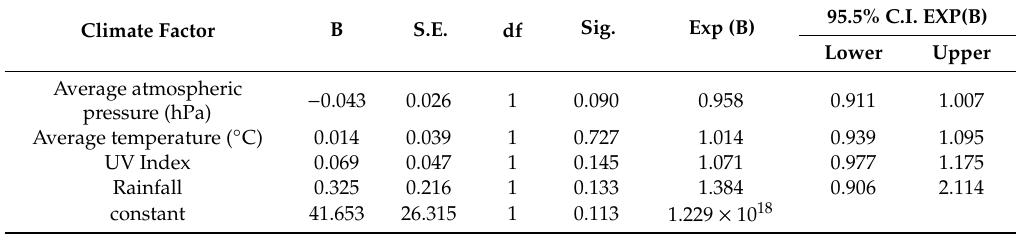
Table 3. Multivariate logistic regression analysis on tilapia streptococcosis and climatic factors.